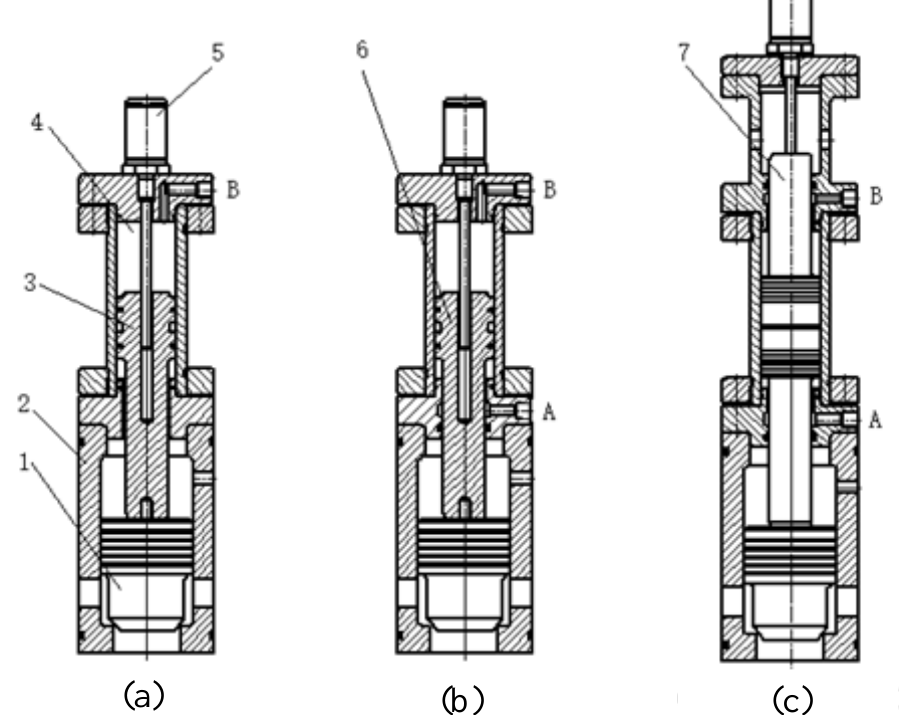
Figure 7. ( a ) Driving mechanism based on a single-acting servo cylinder; ( b ) Double-acting servo cylinder; ( c ) Double-rod servo cylinder.